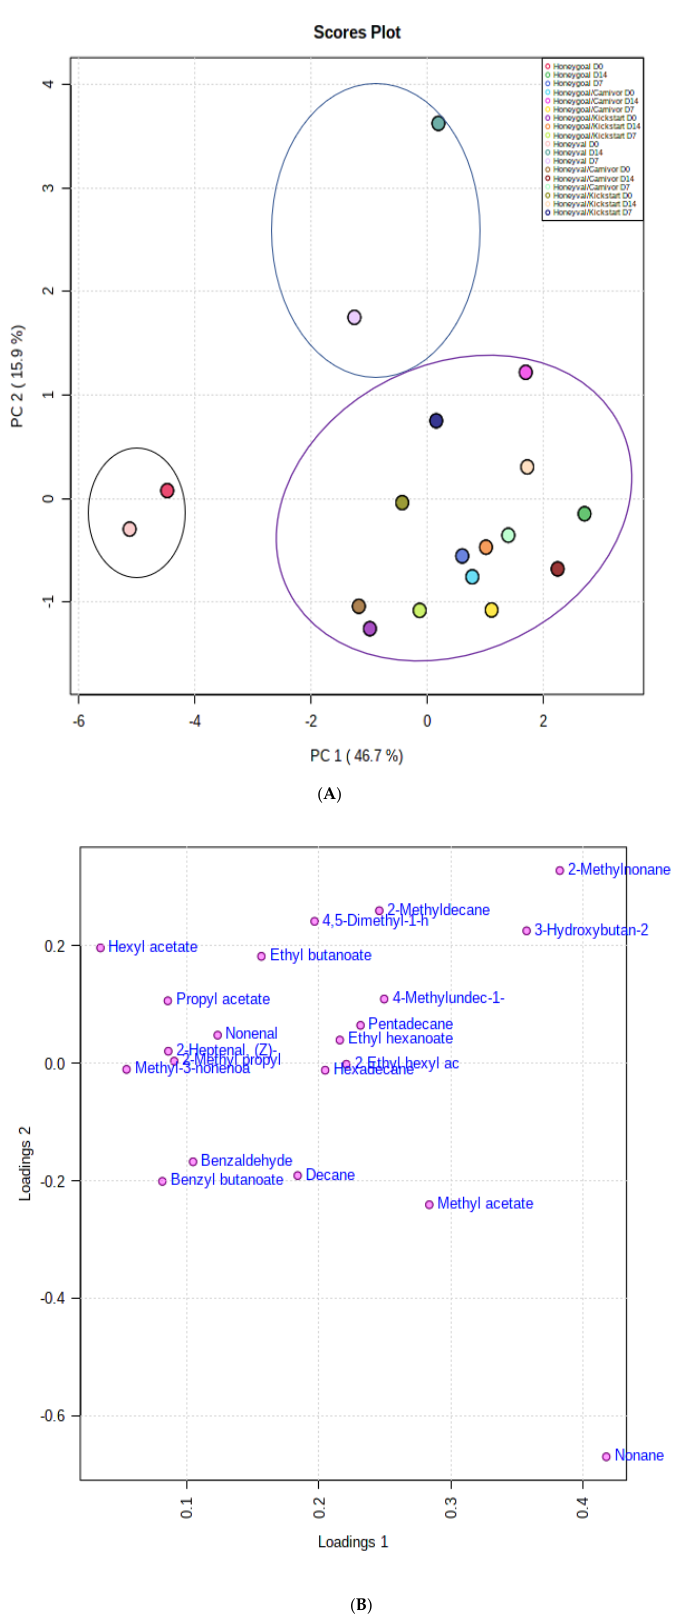
Figure 1. ( A ) Principal component analysis of honeydew rootstocks, cultivars, and volatile compounds after postharvest storage. ( B ) PLS-DA score plot showing the loadings of volatile components of grafted and un-grafted honeydew melons.